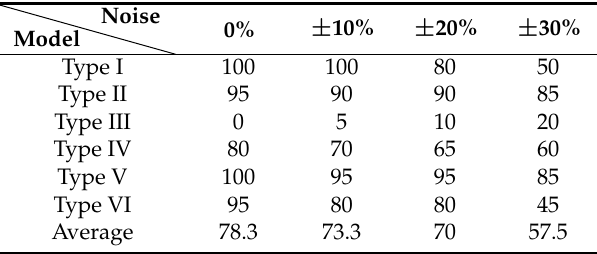
Figure 11. Feature distributions for time–frequency–energy 3D spectrums by HHT. Table 1. Identification results by HHT versus features fractal dimension (FD)- lacunarity ( Λ )- mean-discharged (M).